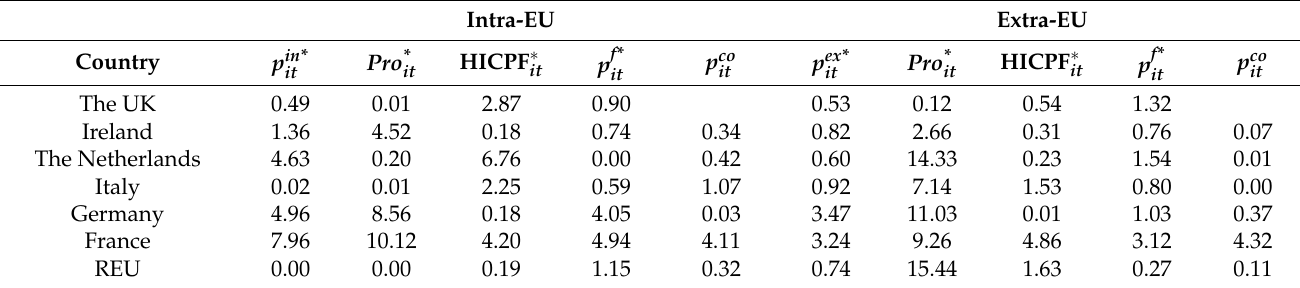
F statistics of weak exogenous test at the 5% significance level of intra-EU and extra-EU